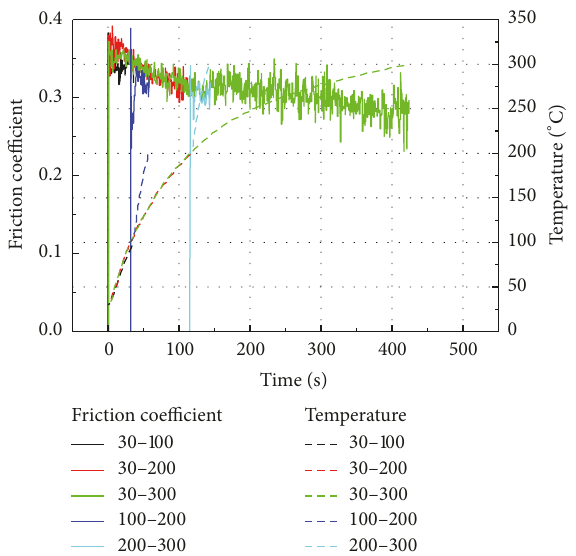
Figure 4: The friction coefficient and temperature change with the sliding time.